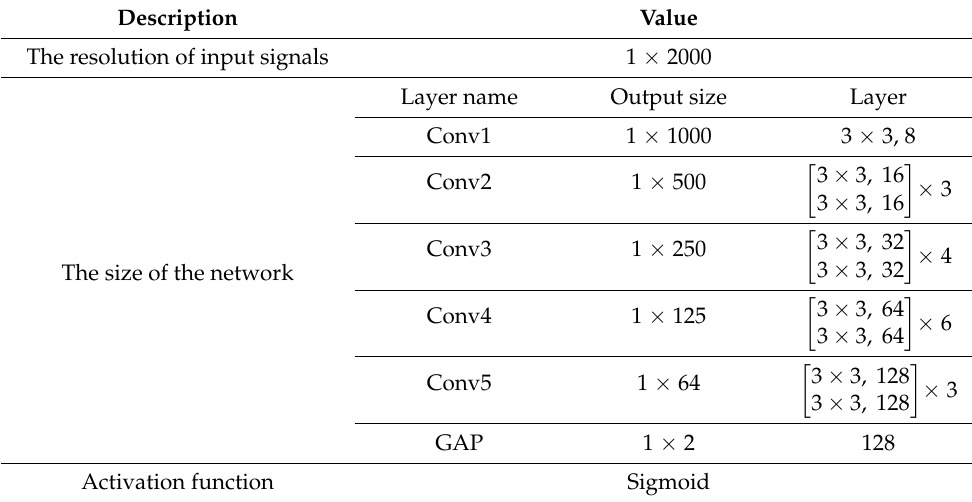
Table 2. Structure parameters of Resnet.